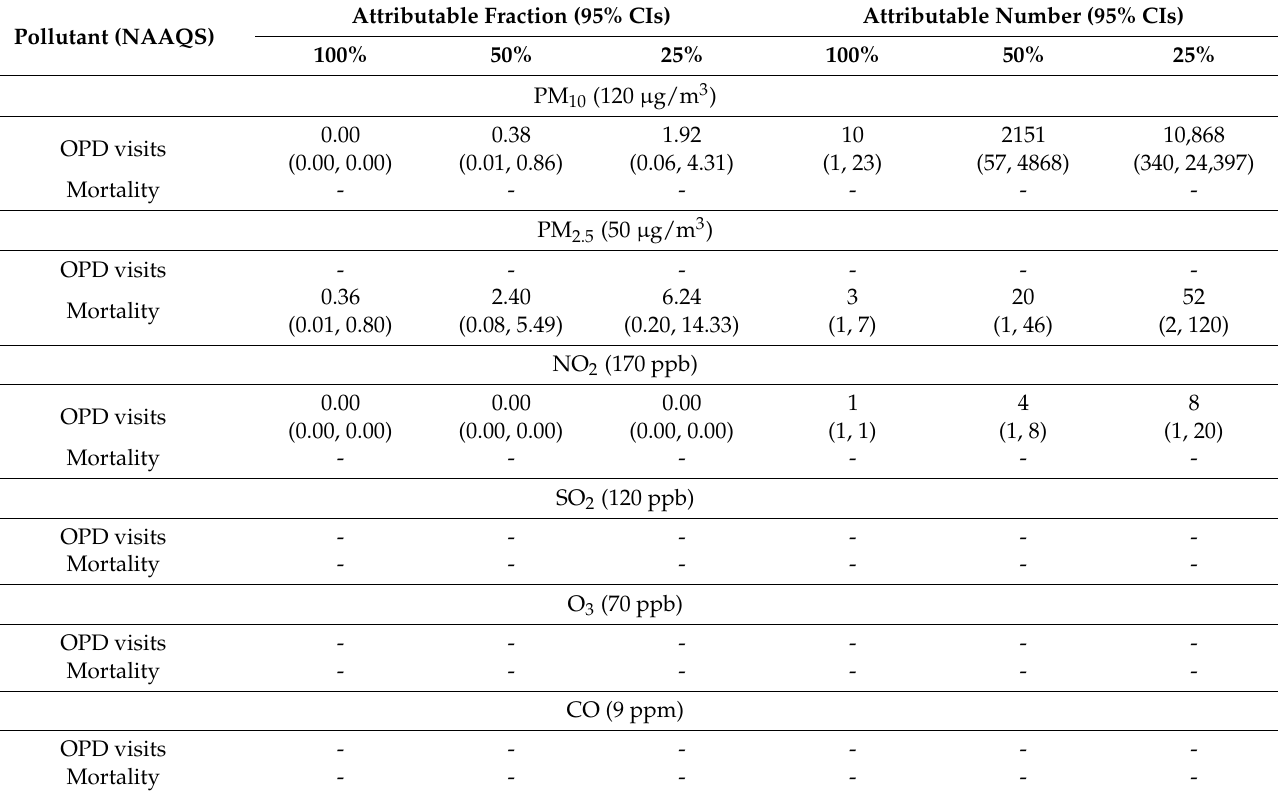
Table 13. Attributable fractions and attributable numbers of outpatient department (OPD) visits and mortalities for chronic lower respiratory diseases caused by air pollutant concentrations in the Eastern Economic Corridor of Thailand exceeded the national ambient air quality standard (NAAQS)